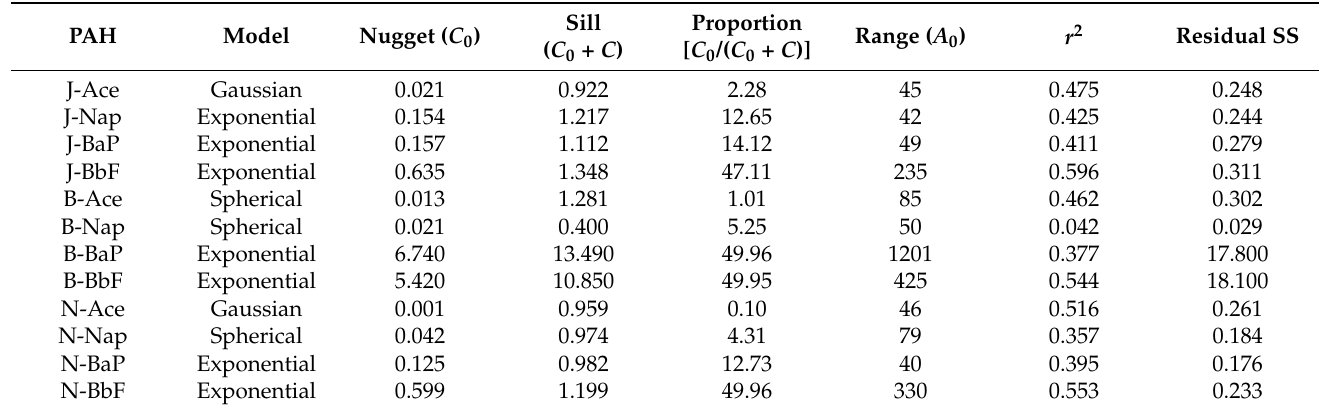
Table 3. Modelled semivariogram parameters of soil PAHs